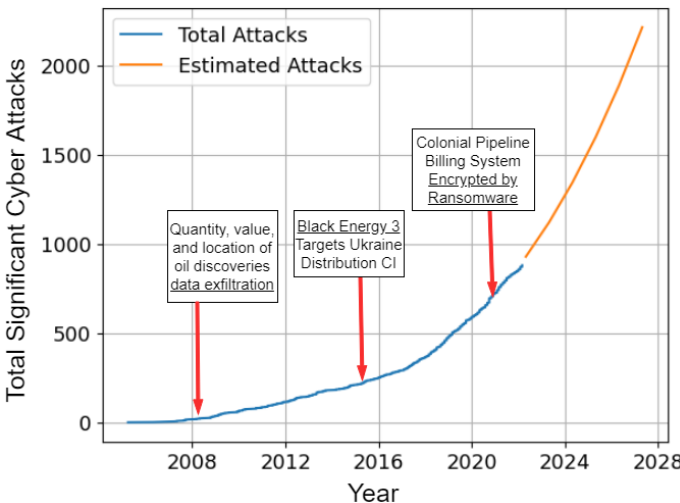
Figure 3. Estimate: cyber attacks will increase